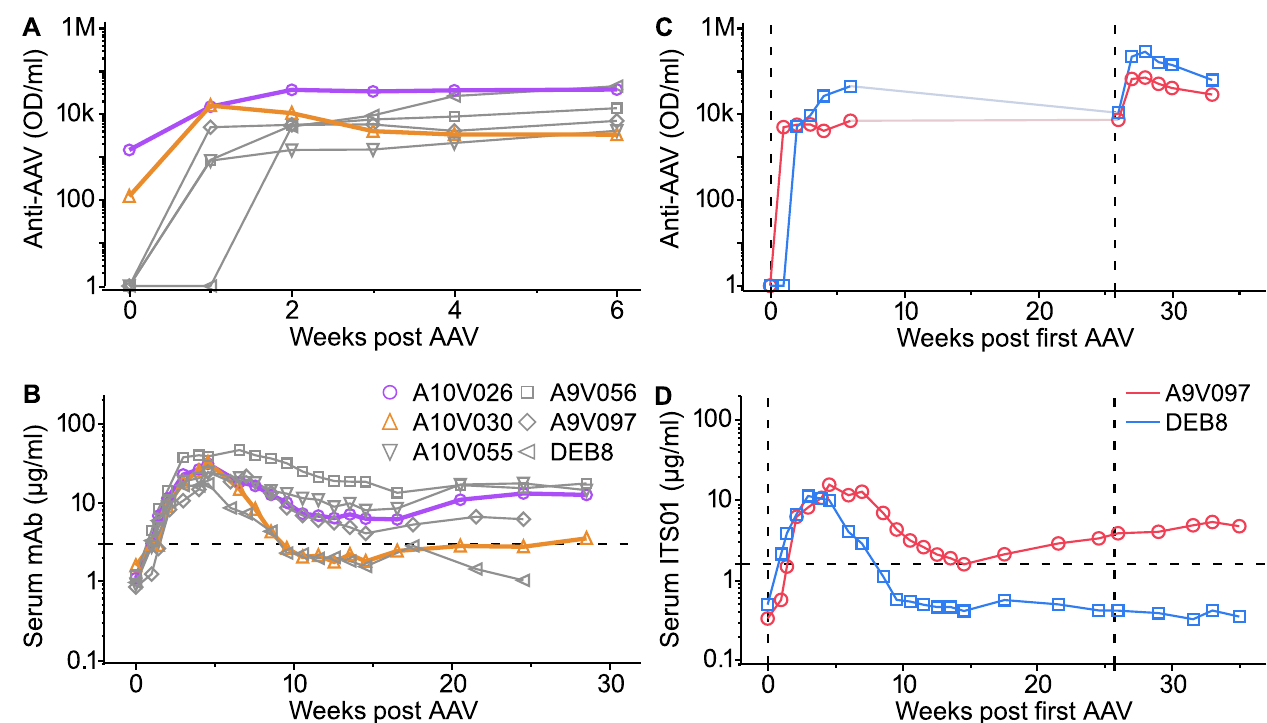
Fig 2. Impact of anti-vector immunity on transgene expression. (A) Anti-vector reactivity and (B) expression of ITS01 is shown for the six animals of Fig 1. Animals with low (A10V030; orange) and intermediate (A10V026; purple) pre-existing anti-vector immunity are highlighted. After 6 months, two of these animals were re-injected with 1 x 10 13 gc AAV8-ITS01 in the right quadriceps. (C) Anti-AAV8 reactivity was boosted, however (D) no increase in serum ITS01 was observed. Anti-AAV8 measurements are in arbitrary optical density (OD 450nm )/ml units.